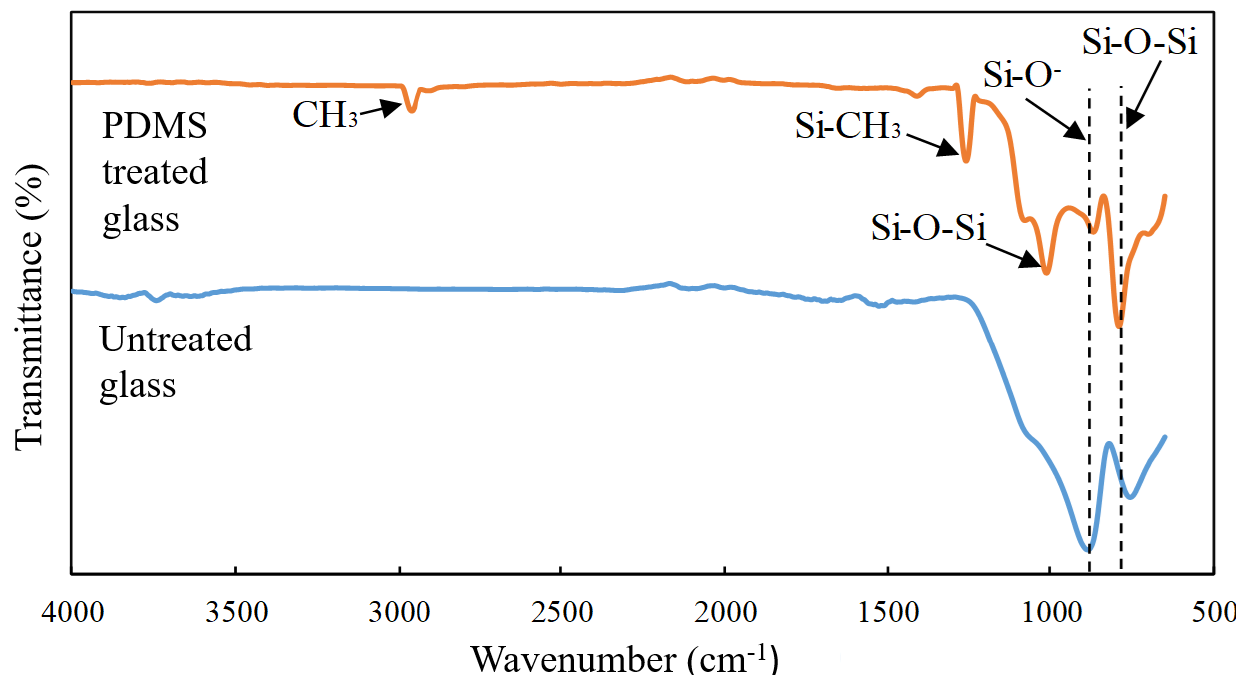
Figure 7. FTIR spectra of the untreated and PDMS-treated borosilicate glass surfaces.